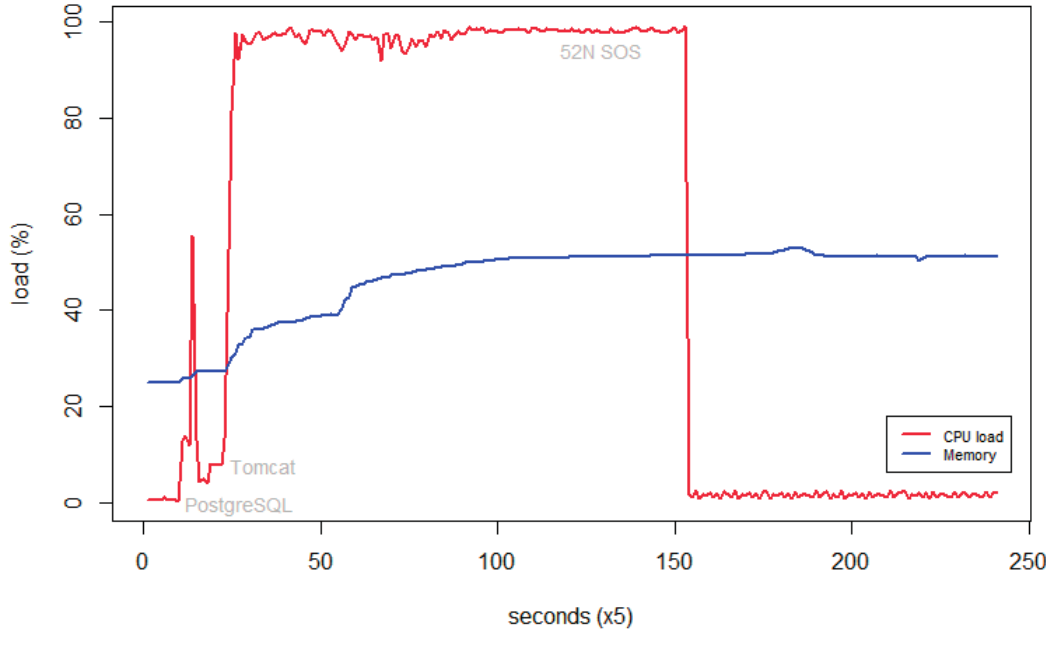
Figure 6. RaspberryPI memory and processor loads after